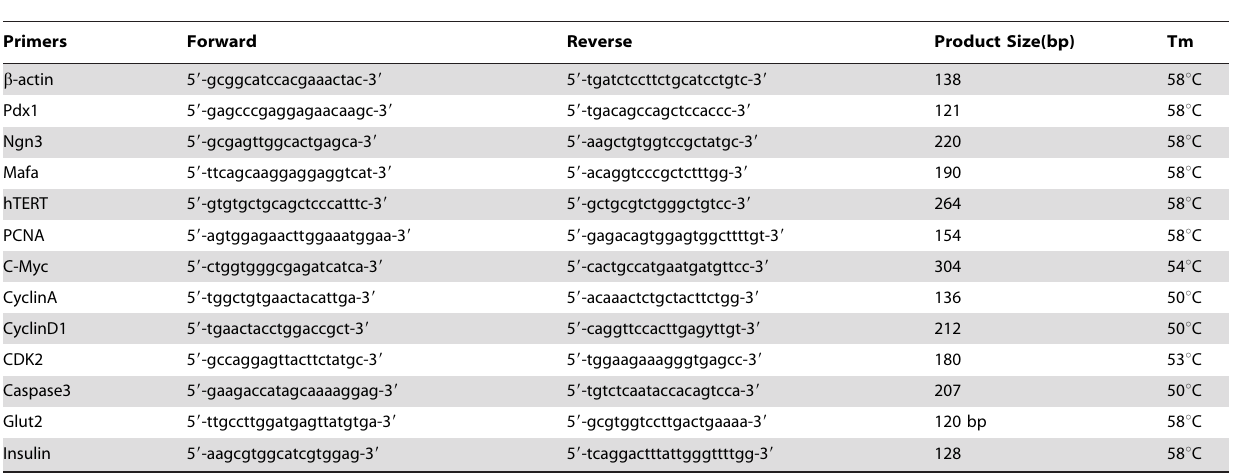
Table 1. The PCR primers and the length of the amplified products.